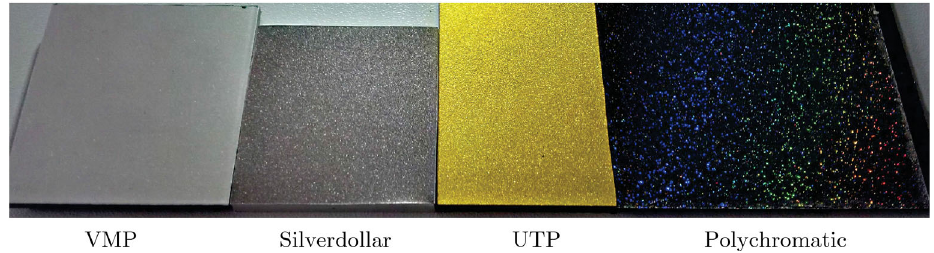
Fig. 3 Four different effect pigments used in the base coats of effect coatings used in our